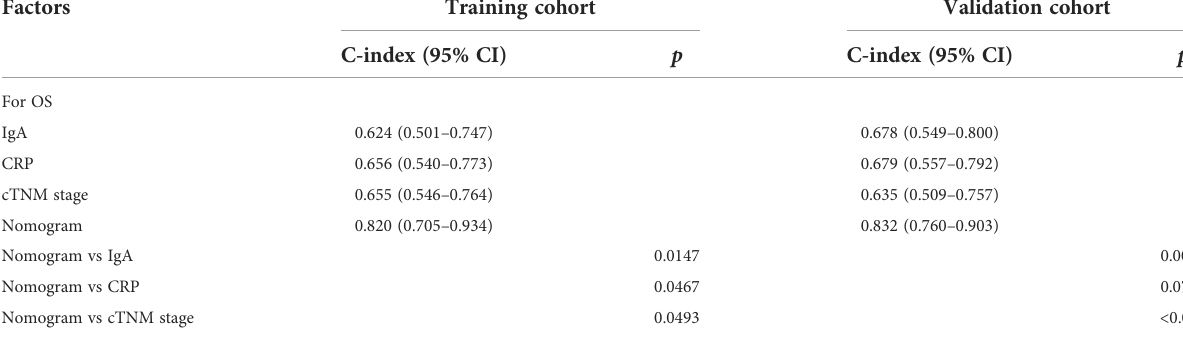
TABLE 3 The C-index of CRP, IgA, clinical TNM stage, and nomogram for prediction of OS.